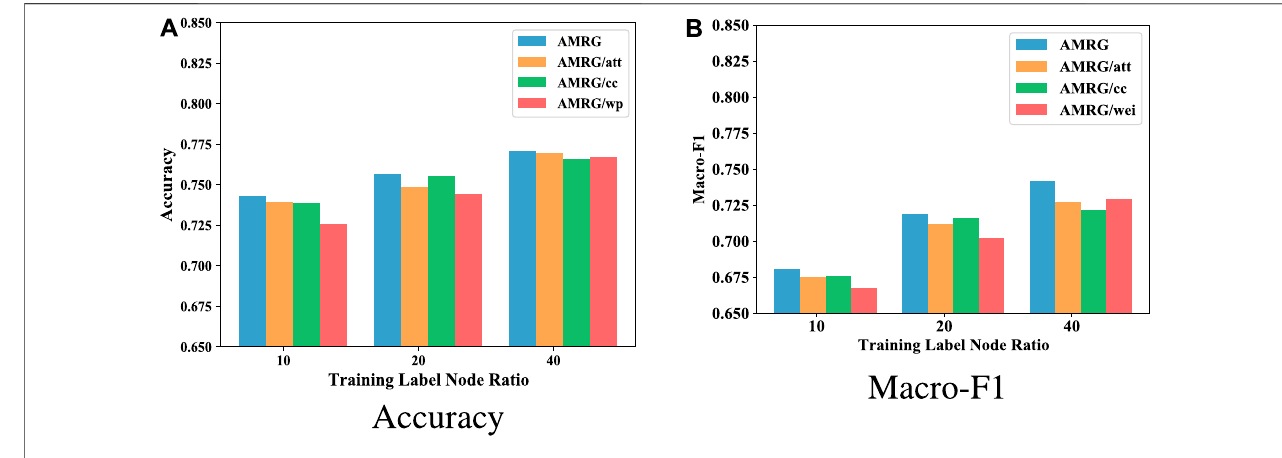
FIGURE 6 | (A) Accuracy. (B) B